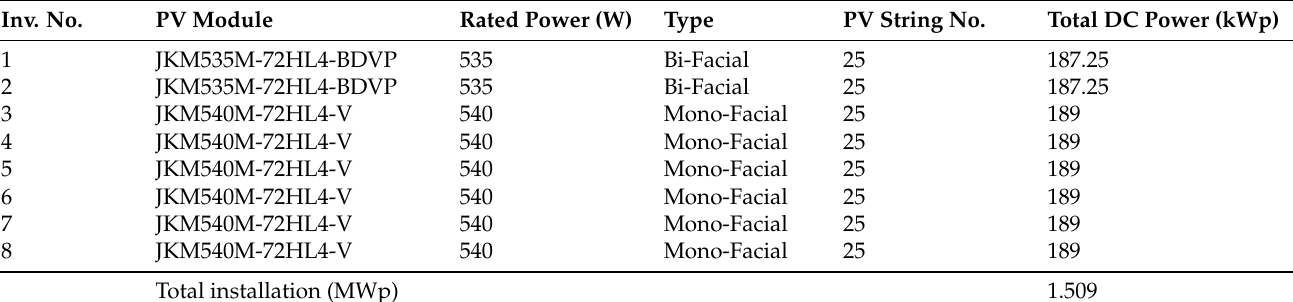
Table 2. Installation details of the floating PV power plant.